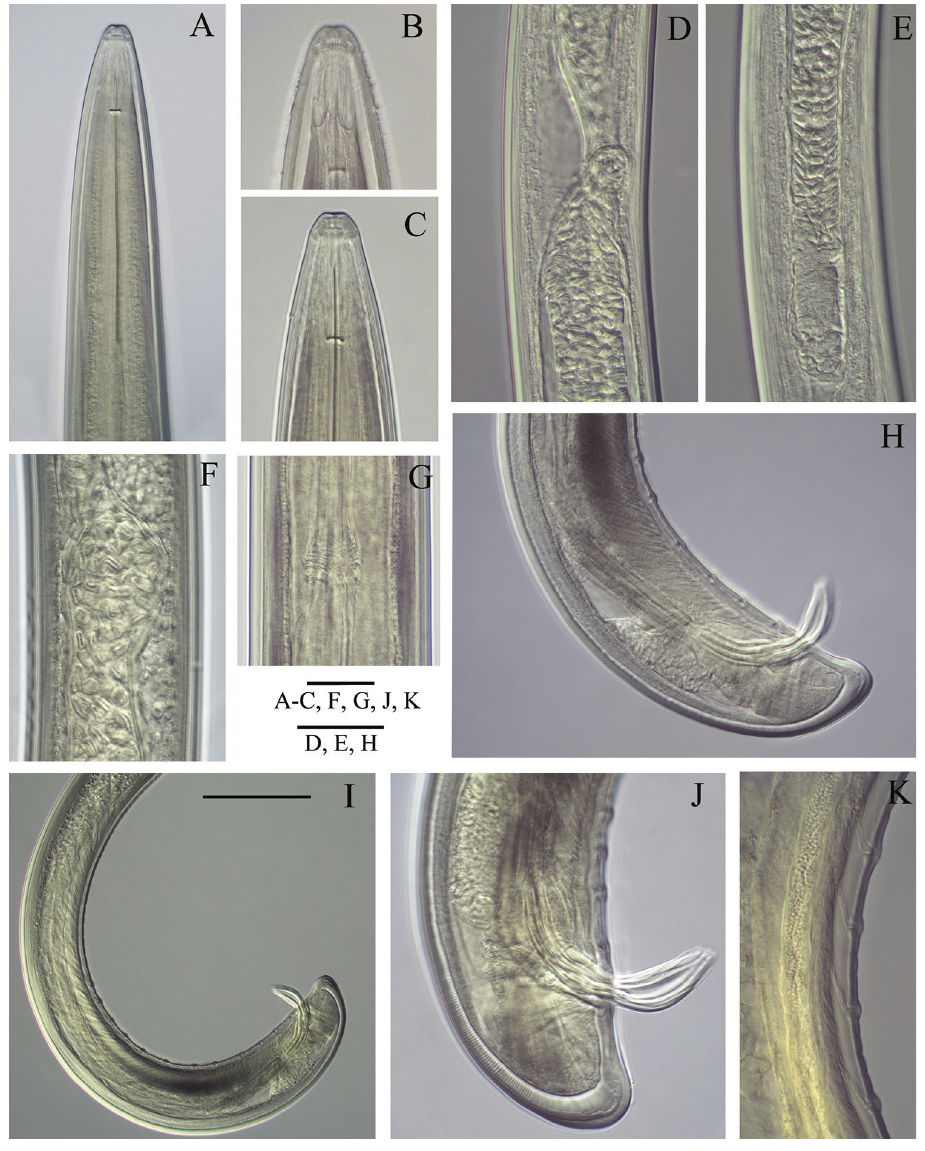
Figure 4. Longidorus polyae sp. n., male A anterior region B amphidial fovea C labial region D junction of two testes E distal part of testis F sperm cells G nerve ring H, I posterior end, different magnifications J tail and spicules K supplements. Scale bars: 20 μm ( A–C, F, G, J, K ); 40 μm ( D, E, H ); 100 μm ( I